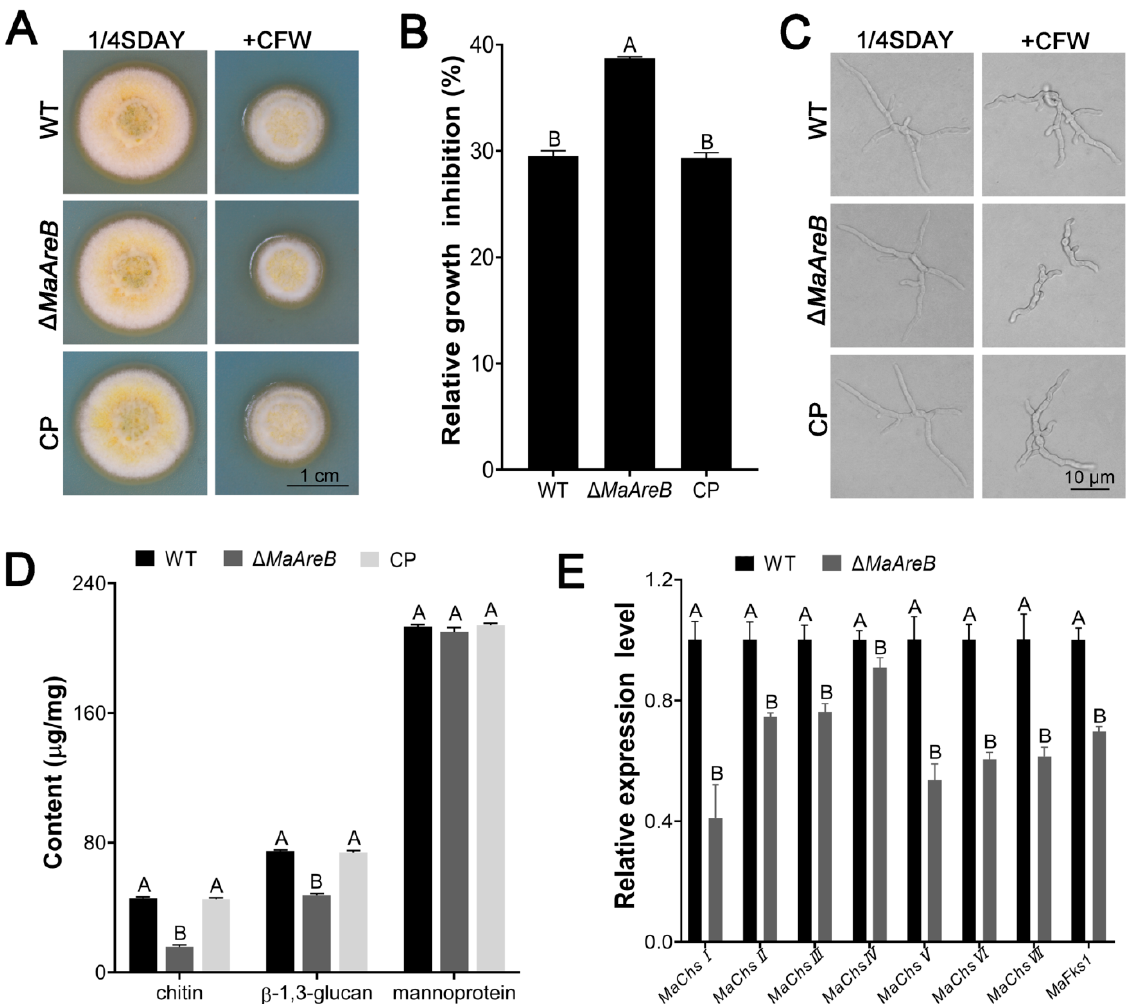
Figure 5. Disruption of MaAreB affected the cell wall integrity. ( A ) Growth of the WT, ∆ MaAreB and CP strains on 1/4SDAY medium without or with 150 μ g/mL CFW. ( B ) Relative growth inhibition rates. ( C ) Microscopic observation of hyphal growth for each strain on 1/4SDAY medium without or with CFW. ( D ) Determination of cell wall compositions for each strain. (E) Transcription levels of genes involved in the cell wall integrity. A & B, p < 0.05 (Tukey’s HSD). The p -values in Figure 5B, D and E are listed in supplementary Table S3.